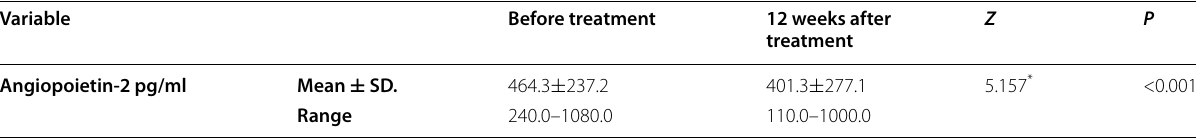
Table 5 Comparison between levels of Angiopoietin-2 before and 12 weeks after EOT